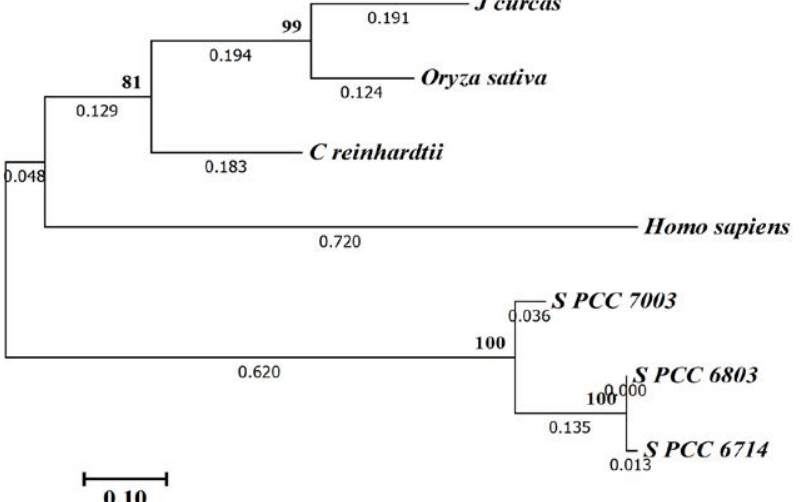
Fig. 2. Molecular phylogenetic tree by Maximum Likelihood method of the Synechocystis PCC 6803 type II Prx protein (S. PCC 6803) with those of the type II Prx proteins from other organisms including Synechocystis PCC 6714 (S. PCC 6714), Synechococcus PCC 7003 (S. PCC 7003), Chlamydomonas reinhardtii, Jatropha curcas, Oryza sativa, and Homo sapiens . The bootstrap consensus tree was from 1000 replicates. Numbers by nodes indicate Maximum Likelihood bootstrap. Evolutionary analyses were conducted in MEGA7 28